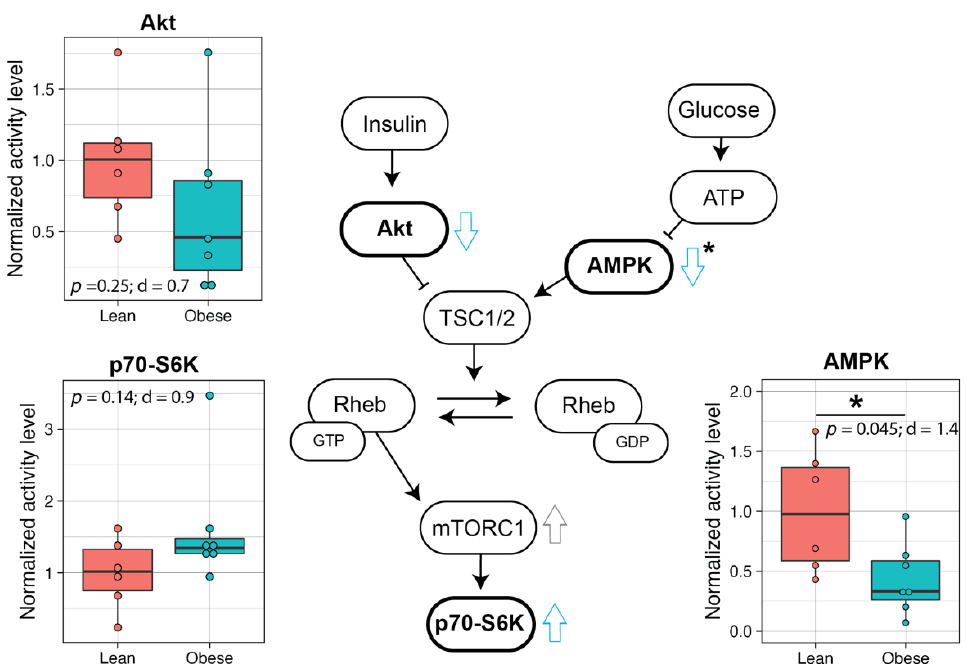
Figure 6. Infants that were born to Obese mothers showed elevated levels of mTOR phosphorylated proteins in the prefrontal cortex. The overall scheme of the mTOR pathway with normalized phos- phorylation levels (phospho-protein/total-protein) of Akt, AMPK, and p70-S6K that were measured in the prefrontal cortex. t -tests were used to test for group differences and statistical significance between groups is denoted with an asterisk. The data are expressed as the mean ± SE, and the red and blue bars correspond to the Lean and Obese groups, respectively. The trends that were found in the brains of infants from the Obese group compared to the Lean group are denoted with blue open arrows. Statistical significance is indicated with “*”. For box plots, each dot represents data from an individual animal. Top and bottom of the boxes represent the 25th and 75th percentiles respectively; the middle line represents the median; and the top and bottom whiskers represent maximum and minimum values. Points outside of the whiskers represent outliers. The sample size is Lean = 6, Obese = 7. Abbreviations: TSC1/2, Tuberous sclerosis proteins 1 and 2; Rheb, Ras homolog enriched in brain; Eff, effect size.